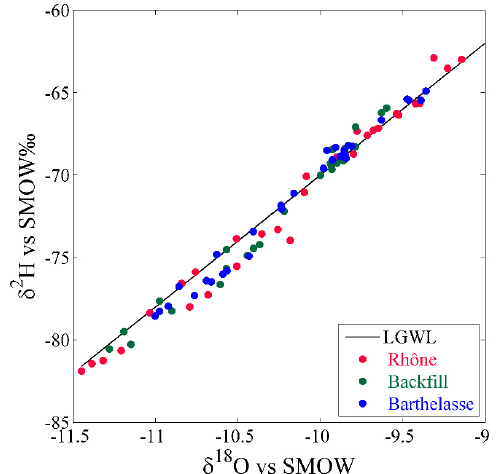
Figure 6. Relationships between δ 2 H and δ 18 O in water samples with the bi-monthly collected from 02/2018 to